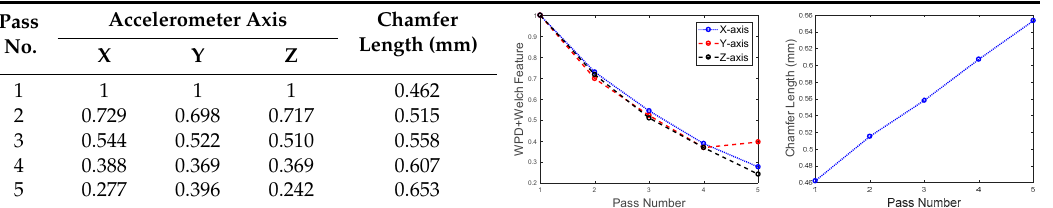
Table 2. The vibration features of the three axes for the training data.